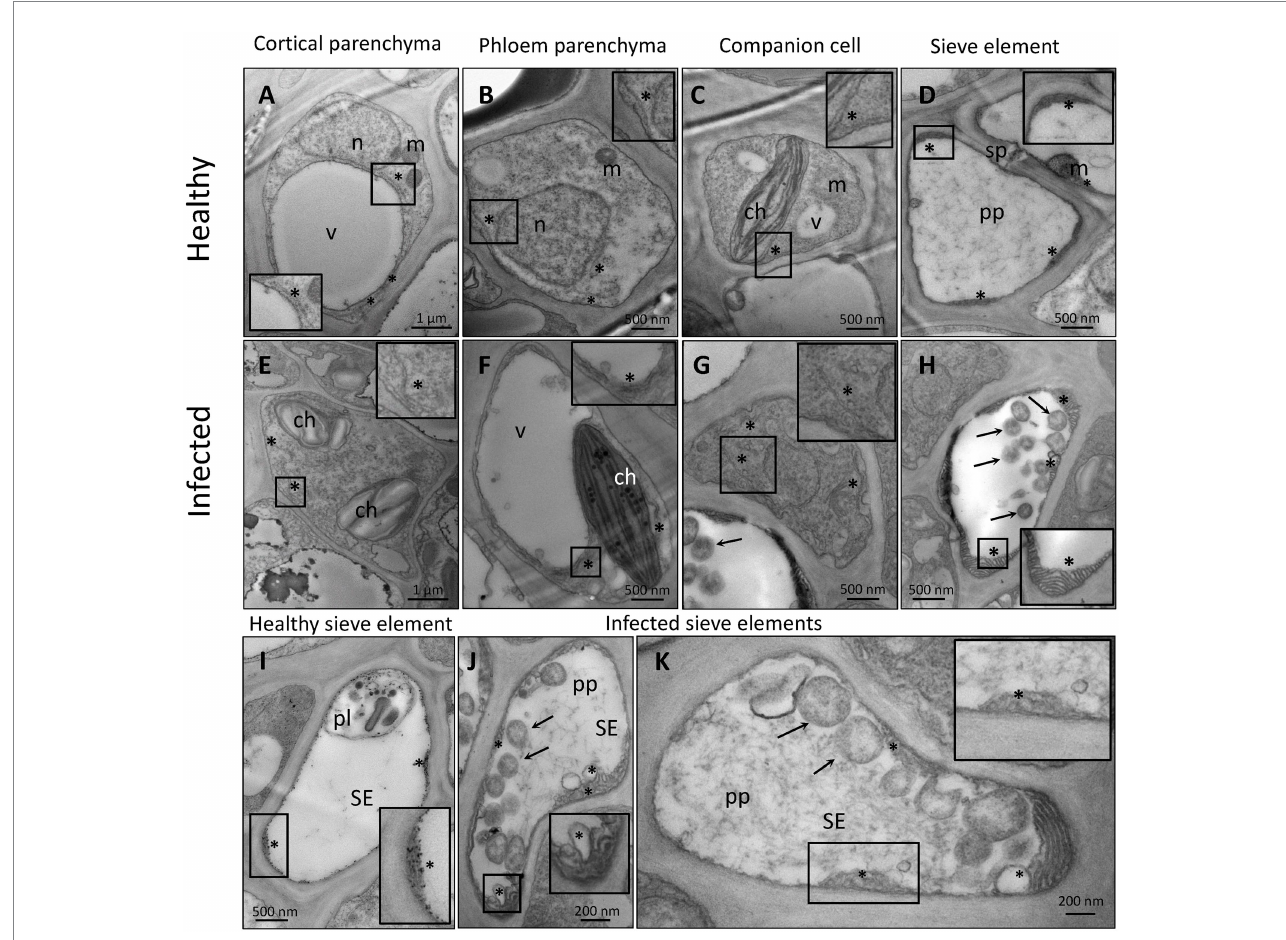
FIGURE 1 Representative TEM micrographs of healthy (A–D,I) and phytoplasma-infected (E–H,J,K) midrib cell types of Arabidopsis. In healthy midribs (A–D,I) , rough endoplasmic reticulum (r-ER) shows a conventional morphology in cortical parenchyma cells (A) , phloem parenchyma cells (B) , and companion cells (C) . The r-ER consists of regular tubules dotted with ribosomes, embedded in the cytosolic environment. In healthy sieve elements (D,I) sieve-element endoplasmic reticulum (SE-ER) stacks are free of ribosomes, firmly appressed in the cell perifery and mostly orientated in parallel to the plasma membrane. In infected midribs (E–H, J,K) , the r-ER does not show significant morphological alterations in the diverse cell types as compared to those in healthy plants (E–G) , with exception of the SE-ER in SEs (H,J,K) . The SE-ER shows dramatic conformational alterations such as increased number of stacks and the slackening or swelling of reticular cisternae (H,J,K) . In insets of (A) – (K) areas of interest are magnified. Arrows = phytoplasmas; asterisks: r-ER or SE-ER; ch: chloroplast; m: mitochondrion; n: nucleus; pl.: plastid; pp.: sieve-element protein; v: vacuole; SE: sieve element; sp.: sieve